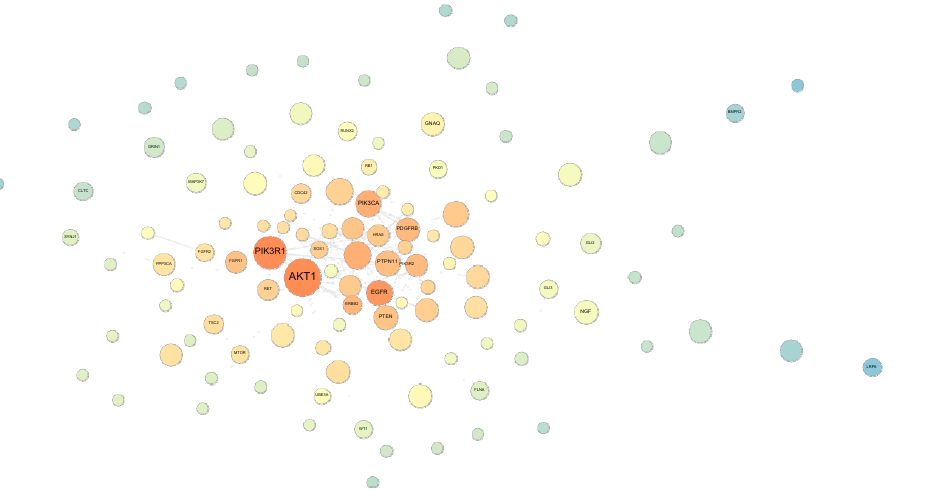
Figure 3. Betweenness centrality and closeness analysis of the STRING network previously generated in Figure 2b using GO and HPO. Large nodes have a more central role in communication among other nodes (hub/hub-like nodes), i.e., more connections. The darker orange the nodes are, the faster information flows towards the central node; i.e., they have the potential to impact the whole network even when having few connections (bottleneck nodes). Thus, nodes can be visualized in four categories: (1) large/dark-orange nodes = hub/bottleneck nodes; (2) large/blue nodes = hub/non-bottleneck nodes; (3) small/dark-orange nodes = non-hub/bottleneck nodes; and (4) small/blue nodes = non-hub/non-bottleneck hubs. NF1 is represented by the yellow node on the right side of AKT1.